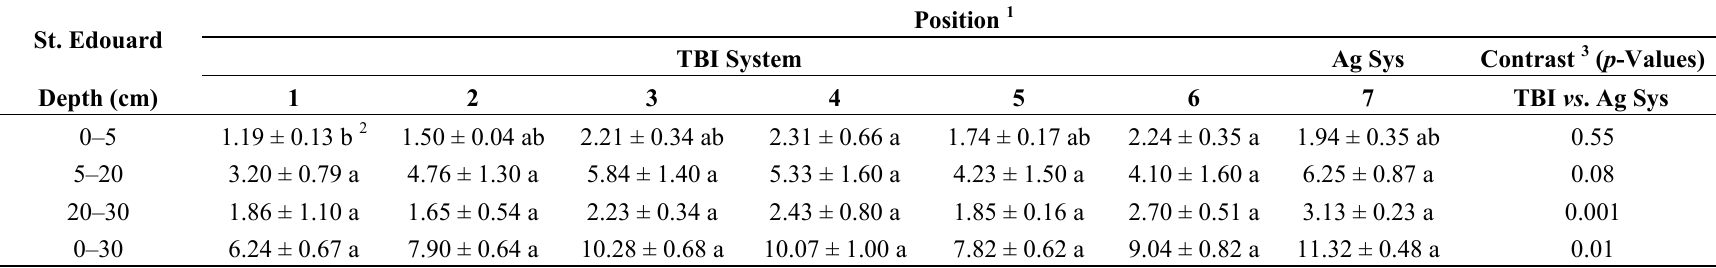
Table 2. Average soil C stocks (kg C m − 2 ± standard deviation, n = 3) for a tree-based intercropping (TBI) system and an adjacent agricultural system (Ag Sys) at St. Edouard, southern Quebec, Canada.